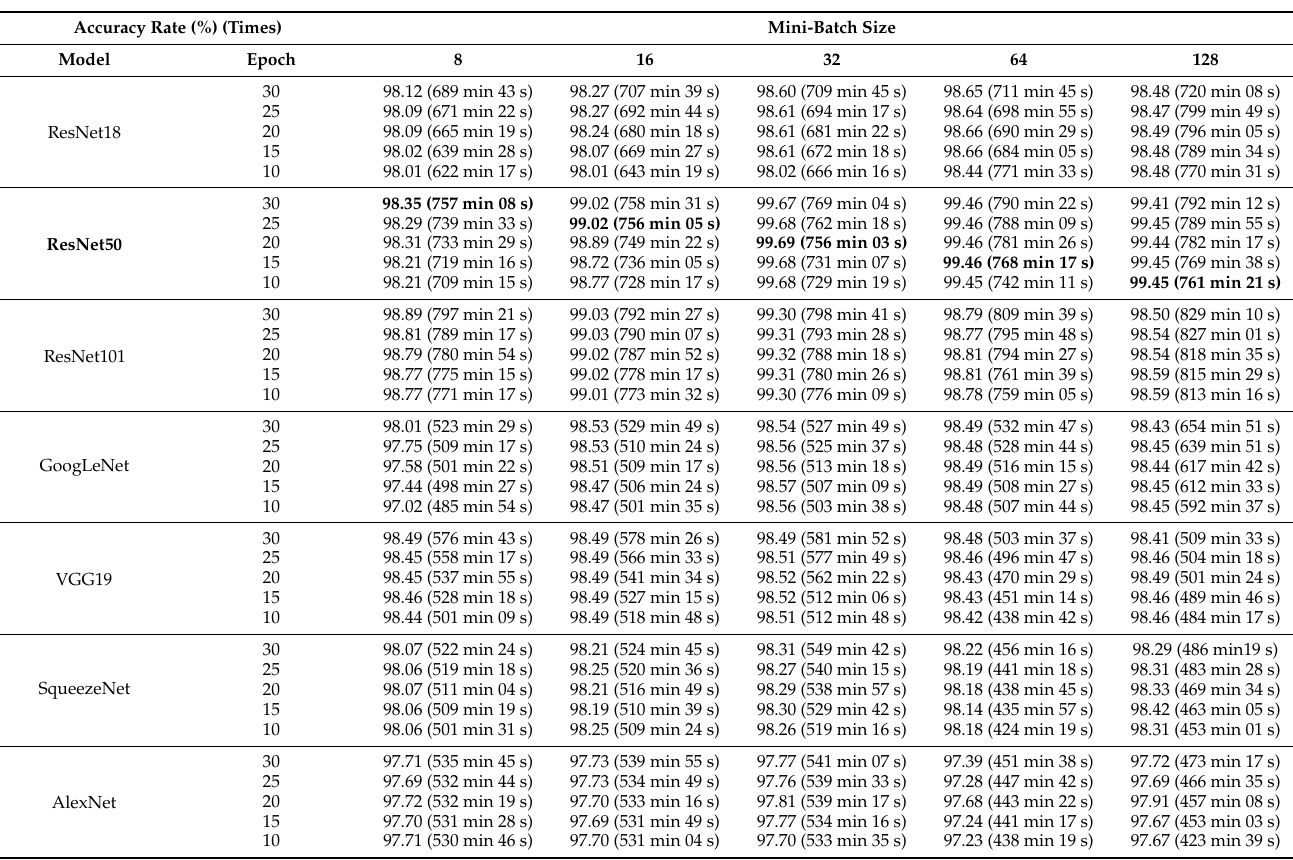
Bold symbols represent the maximum values of each column in the tables. Figure 9. Experiment II: accuracy of nine classes (CRC-VAL-HE-100K).